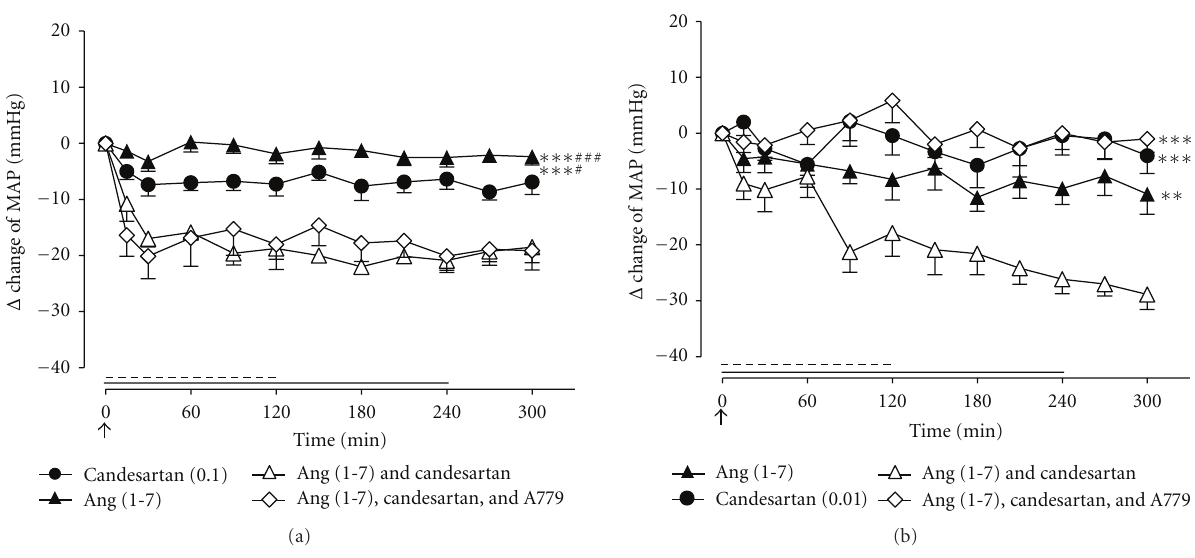
Figure 3: E ff ect of Ang (1-7) (15 pmol/kg/min; 4-hour infusion depicted by full line), AT 1 R antagonist, and candesartan in (a) adult WKY rats (0.1mg/kg bolus IV; depicted by an arrow) and (b) aged WKY rats (0.01 mg/kg bolus IV; depicted by an arrow), together with Ang (1-7) + candesartan and Ang (1-7) + candesartan + Mas R antagonist A779 (15pmol/kg/min for 2 hours; depicted by dashed line), on MAP ( n = 8 for both groups). Values represent mean ± SEM. (a) ∗∗∗ P < 0 . 001, for treatment e ff ect of Ang (1-7) + candesartan versus Ang (1-7) or candesartan alone (2-way RM ANOVA), † < 0.05; ††† < 0.001, for treatment e ff ect of Ang (1-7) + candesartan +A779 versus candesartan or Ang (1-7) alone (2-way RM ANOVA). (b) ∗∗ P < 0 . 01; ∗∗∗ < 0.001 for treatment e ff ect of Ang (1-7) + candesartan versus Ang (1-7), candesartan, or Ang (1-7) + candesartan + A779 (2-way RM ANOVA).